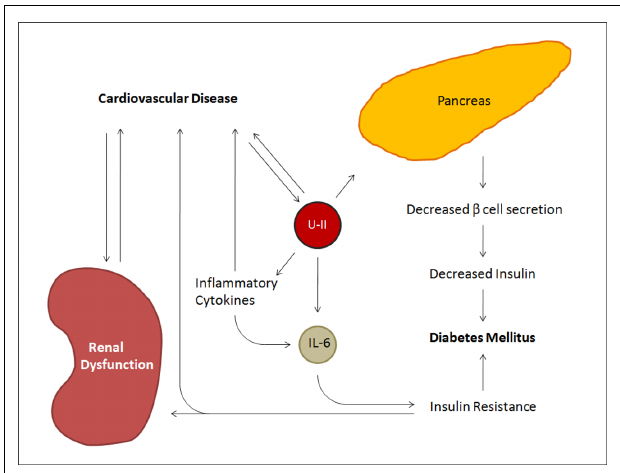
FIGURE 3 | Summary schematic of the effects of UII on the metabolic syndrome. In addition to the cardiorenal aspects influenced by urotensin, UII increases circulating levels of inflammatory cytokines, including IL-6, resulting in insulin resistance. It further acts directly on the pancreas to decrease beta cell secretion.